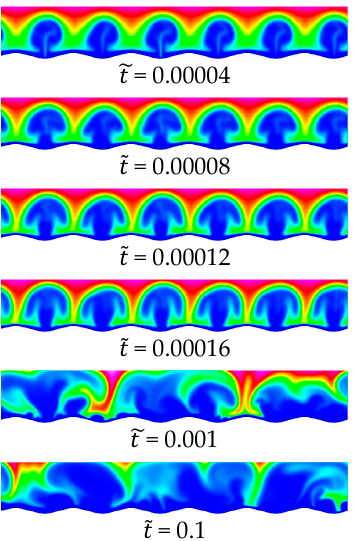
Figure 13. Baseline 2-D case, (cid:101) V = 120. Wavy membrane with A = 0.5 µ m and λ = 10 µ m. Anion concentration.